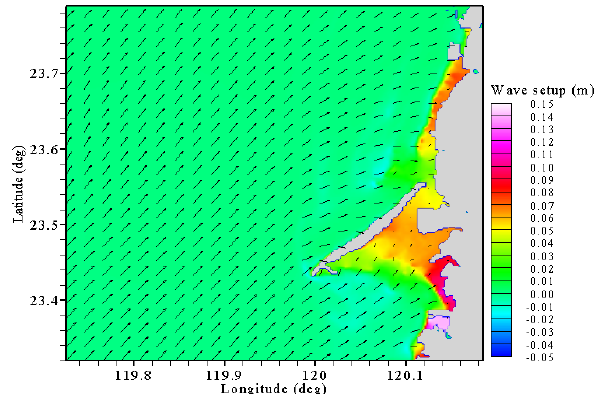
Figure 16 Wave height and runup presented by the operational models Fig. 16. Wave height and runup presented by the operational